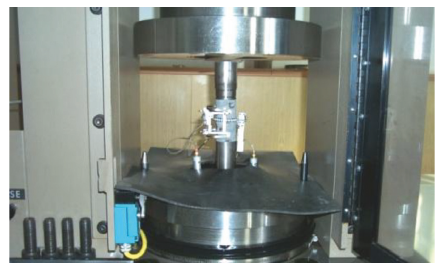
Figure 3: Standard rock samples in the